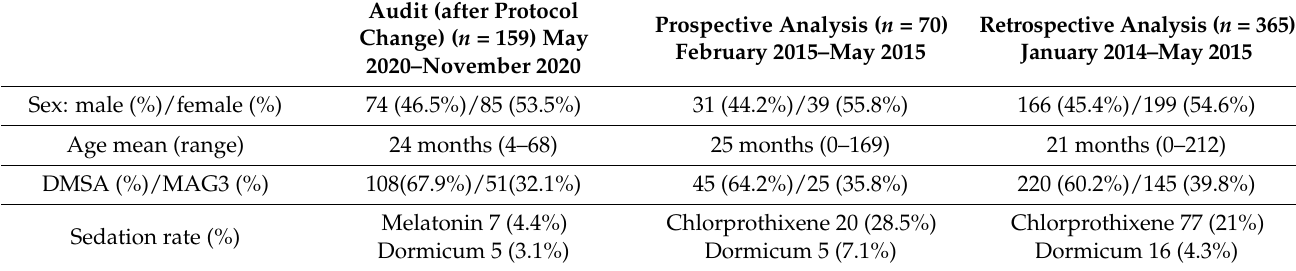
Table 1. Patient characteristics for the new and old protocol (prospective and retrospective cohort). Audit (after